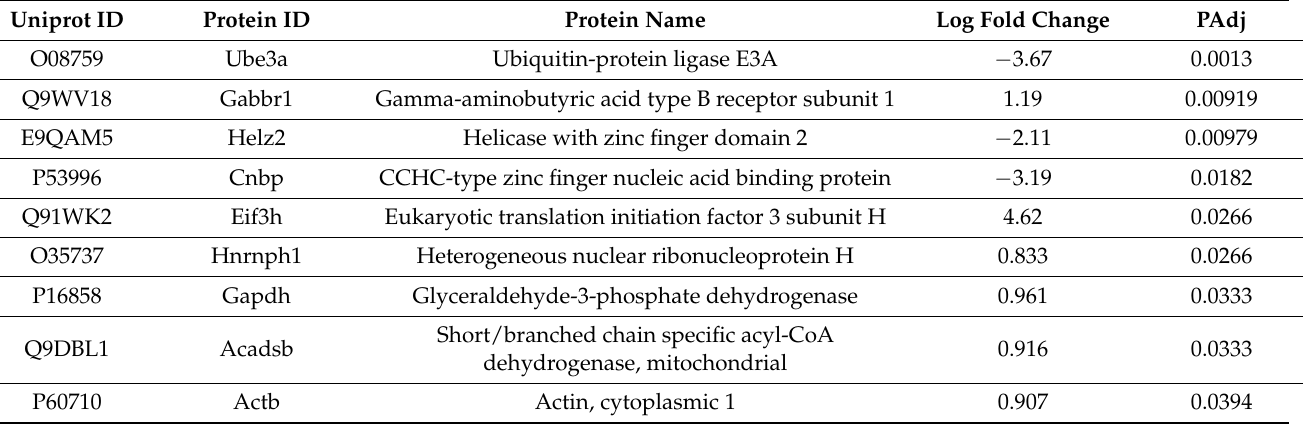
Table 2. List of DEPs between the 2-week (un)treated hippocampal protein datasets. Overall, proteins are ranked by p -value from most significant to least